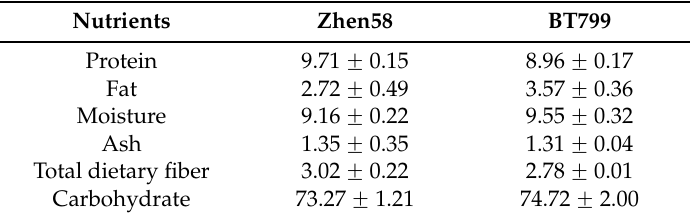
Table 3. Nutritional composition of two kinds of maize flour in g/100g.